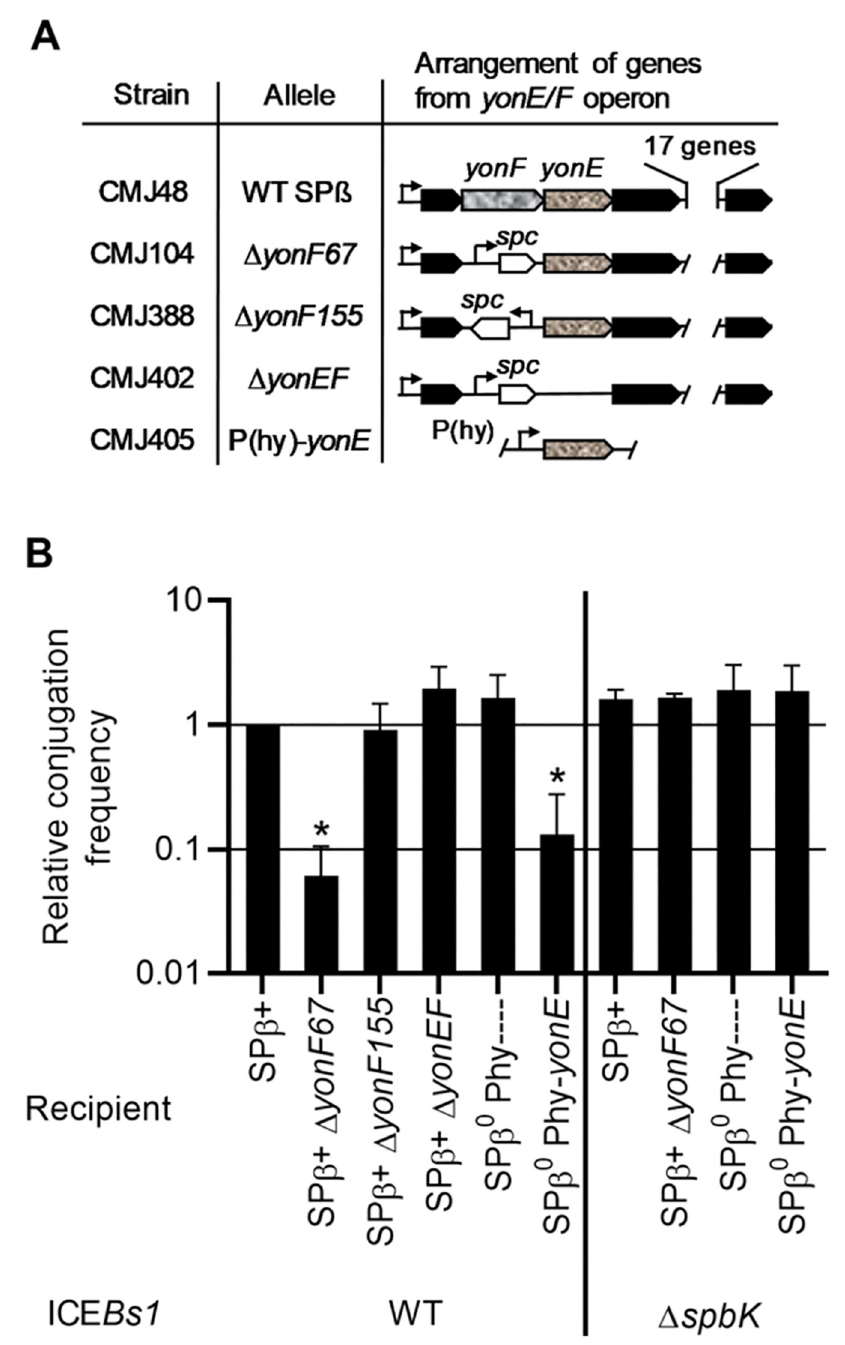
Fig 4. Expression of yonE in recipients reduces acquisition of ICE Bs1 via conjugation. A. Map of the operon in SPß that contains yonF and yonE , and relevant mutations. Genes are shown as arrows. yonF and yonE are indicated by arrows filled with a mottled pattern. spc is shown as an open arrow. Promoters are shown as bent arrows. The allele and the recipient strain carrying that allele are indicated. B. The relative conjugation frequencies are shown, normalized to the conjugation frequency between a donor carrying a wild type ICE Bs1 (KM250) and a recipient with a wild type SPß (CMJ48) within the same experiment, (average 9.7 x 10 − 4 ± 1.3 x 10 − 3 transconjugants/donor). The Δ spbK donor (CMJ431) carries an ICE Bs1 in which spbK-rapI-phrI have been deleted. The recipient with the promoter Pspank(hy) and no yonE allele is CMJ405. Other recipient strain numbers are indicated in panel A. Each experiment was repeated � 3 times. Asterisks indicate that the conjugation frequency with the given recipient is significantly different than that with the wild type control (p < 0.05, t-test).